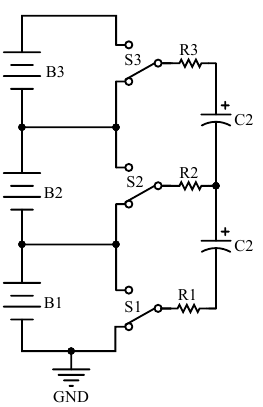
Figure 2. Switched capacitor converter balancing method.